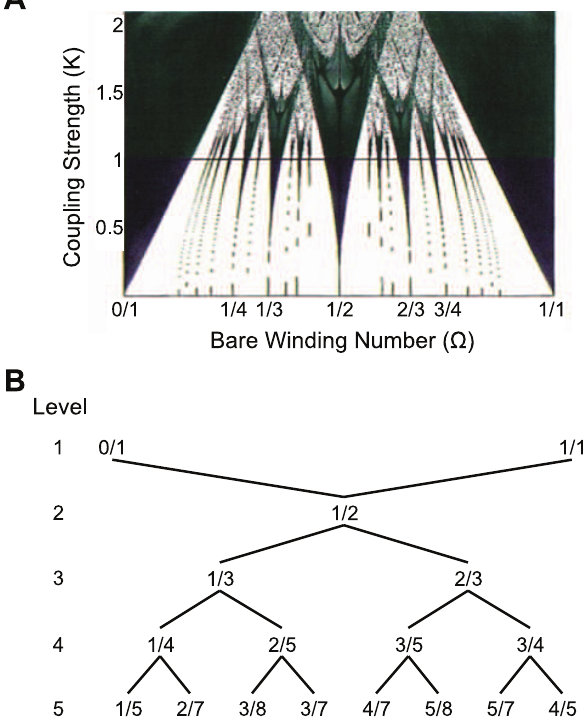
Figure 1. Representation of Arnold Tongue and the first five level of the Farey tree. A. Regime diagram: For a particular coupling strength ( K ), specific mode locks occur within ranges of V (the ratio P/Q when the oscillators are uncoupled: the ‘bare’ winding number). The larger a particular range, the more stable is the associated mode-locked ratio. Arnold’ tongues for ratios up to Farey level 8 are displayed. Darker regions correspond to more stable behavior (Reprinted from ‘‘Springer and Biological Cybernetics, Volume 73 (1995) 301–309, Peper et. al. , Original Copyright (c) 1995, Springer Publishing Company, LLC’’, with kind permission from Springer Science and Business Media). B. Five first levels of the Farey tree: this hierarchical mathematical structure corresponds to the organization of frequency ratios as predicted by the sine circle map. Lower-level frequency ratios are more stable than higher-level